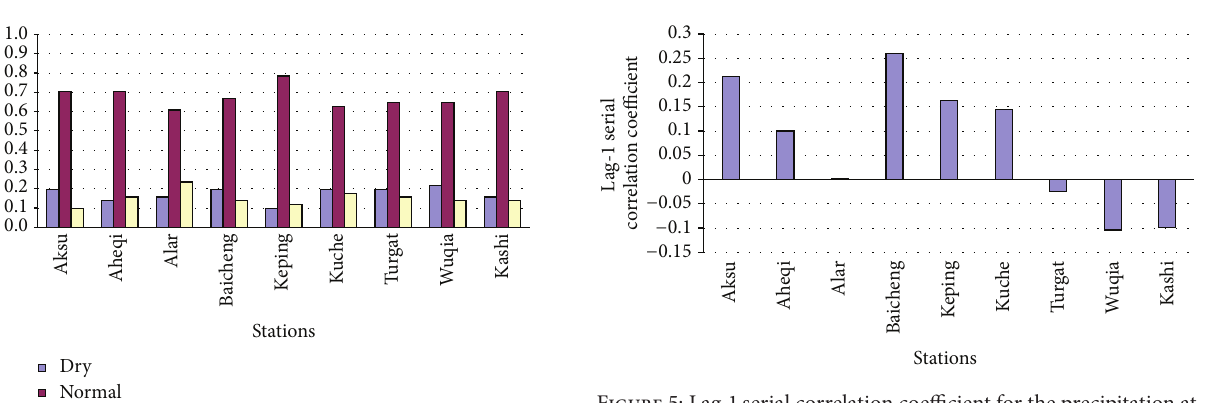
Figure 5: Lag-1 serial correlation coefficient for the precipitation at the synoptic stations. Table 5: Lag-1 serial correlation coefficients for seasonal precipita- tion